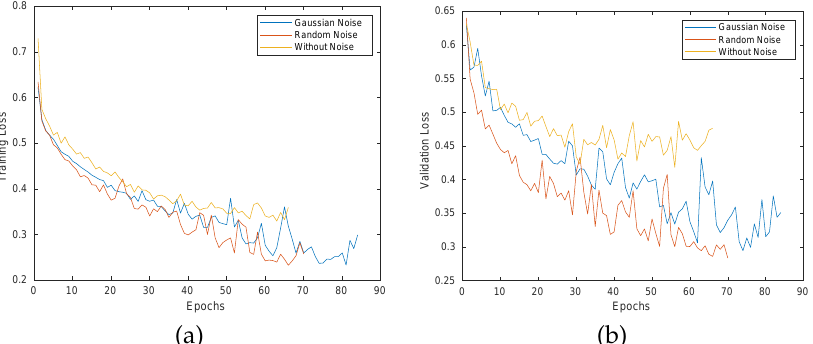
Figure 7. Training and validation loss of proposed model, ( a ) shows the training and validation MAE for the model with Gaussian noise, and ( b ) shows the training and validation MAE with random